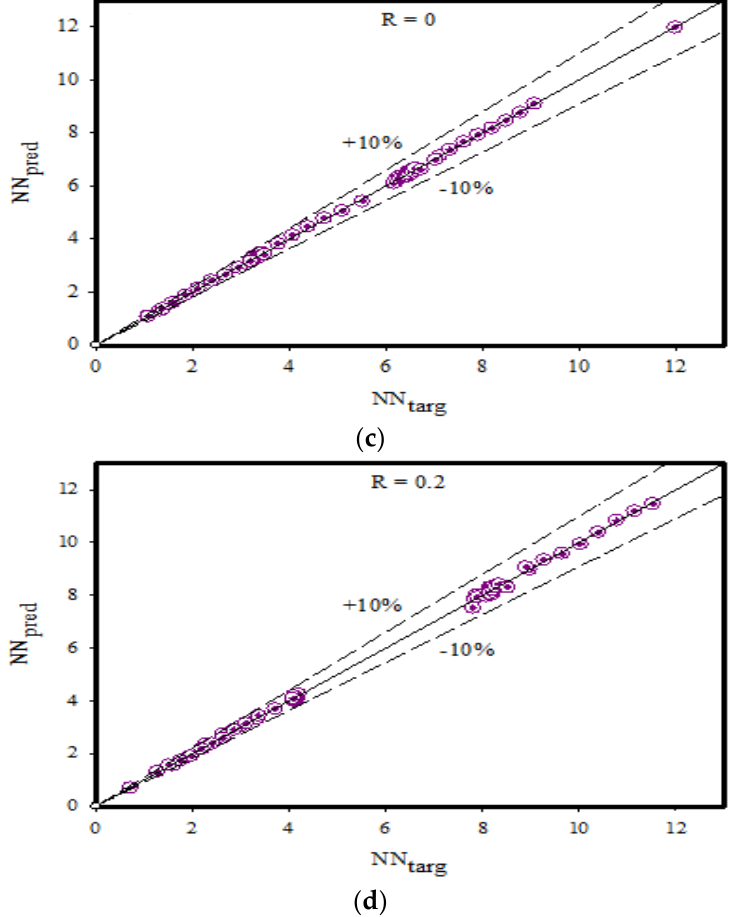
Figure 8. ( a ) Target and prediction values without heat generation effect. ( b ) Target and prediction values with heat generation effect. ( c ) Target and prediction values without radiation effect. ( d ) Target and prediction values with radiation effect. Table 15. The performance parameters calculated for four different ANN models developed.